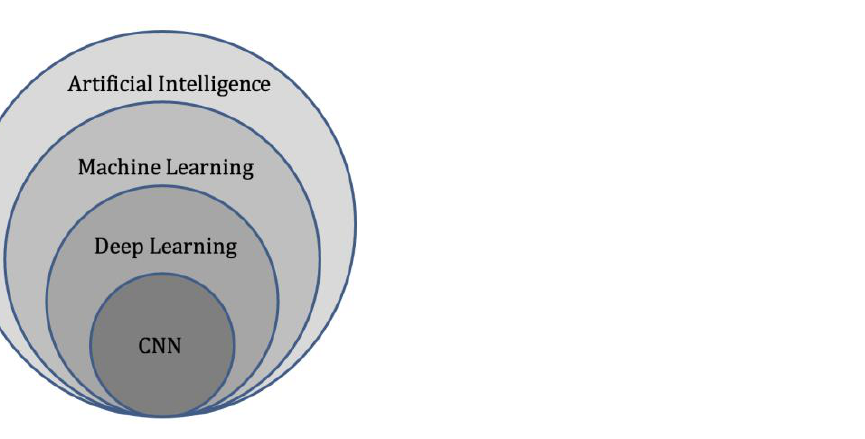
Figure 3. Diagram of artificial intelligence hierarchy. Machine learning lies within the field of artifi- cial intelligence and is an area of study that enables computers to learn without explicit knowledge or programming. Within machine learning, deep learning is another area of study that enables computation of neural networks involving multiple layers. Finally, convolutional neural networks (CNN) are an important subset of deep learning, commonly applied to analyse medical images.